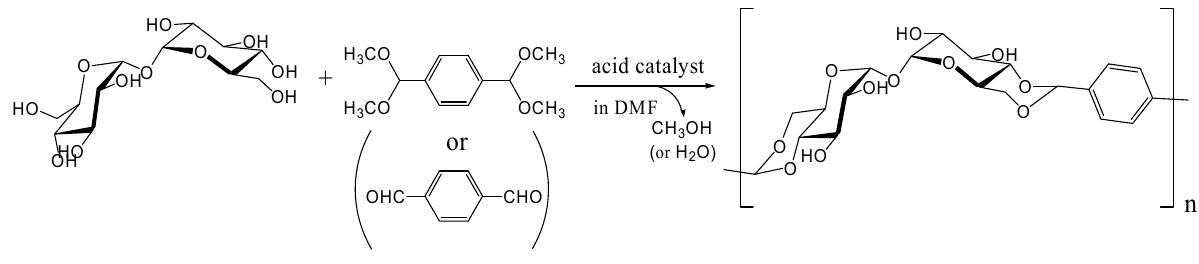
Figure 16. Polyacetal synthesis by the acetalization reaction of trehalose with dialdehyde compounds having two benzaldehyde units on the ends of